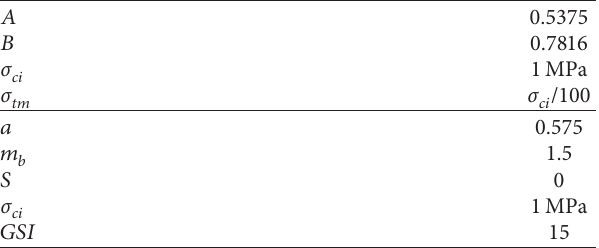
Figure 14: Comparison of the collapse surface of a highway tunnel roof provided by the upper bound theorem and the numerical Table 2: Equivalent parameters for the two forms of the H–B failure criterion.